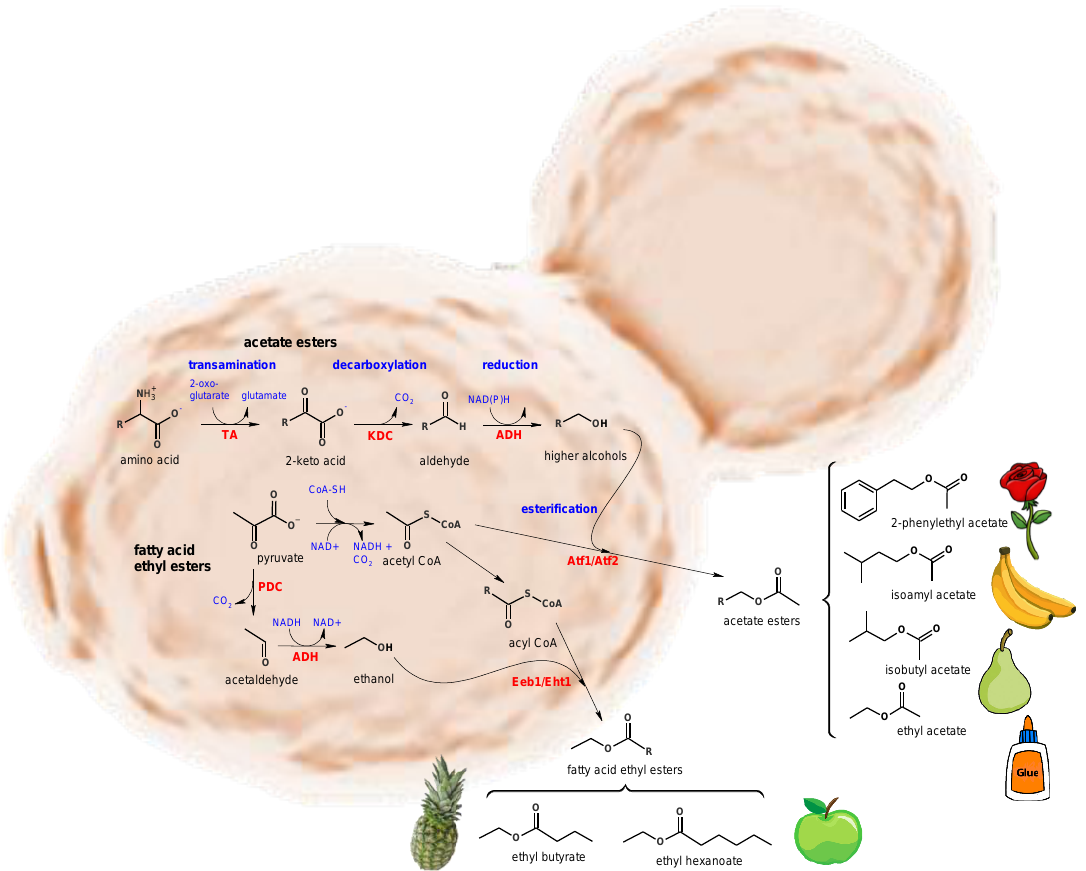
Figure 2. Metabolic pathways involved in the formation of floral and fruity esters in yeasts. Production of acetate esters by Ehrlich catabolism of amino acids and production of fatty acids ethyl esters ( TA: transaminase, KDC: 2-keto acid decarboxylase, ADH: alcohol dehydrogenase, Atf: acyltransferase). Formation of fatty acid ethyl esters by acylation with acyl-CoA (PDC: pyruvate decarboxylase, ADH: alcohol dehydrogenase, Eeb1/Eht1: ethyl ester biosynthesis/ethanol hexanoyl transferase).